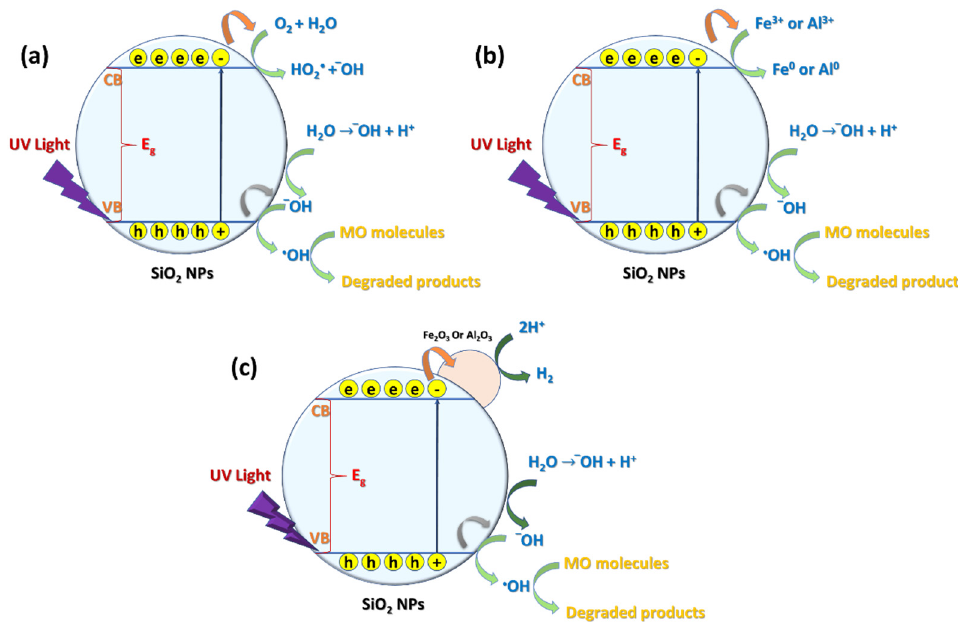
Figure 13. Proposed mechanisms of the photocatalytic effect of ( a ) SiO 2 NPs, ( b ) SiO 2 NPs defiled by Fe 3+ and/or Al 3+ ions, and ( c ) Fe 2 O 3 and/or Al 2 O 3 deposited on the surface of SiO 2 NPs.